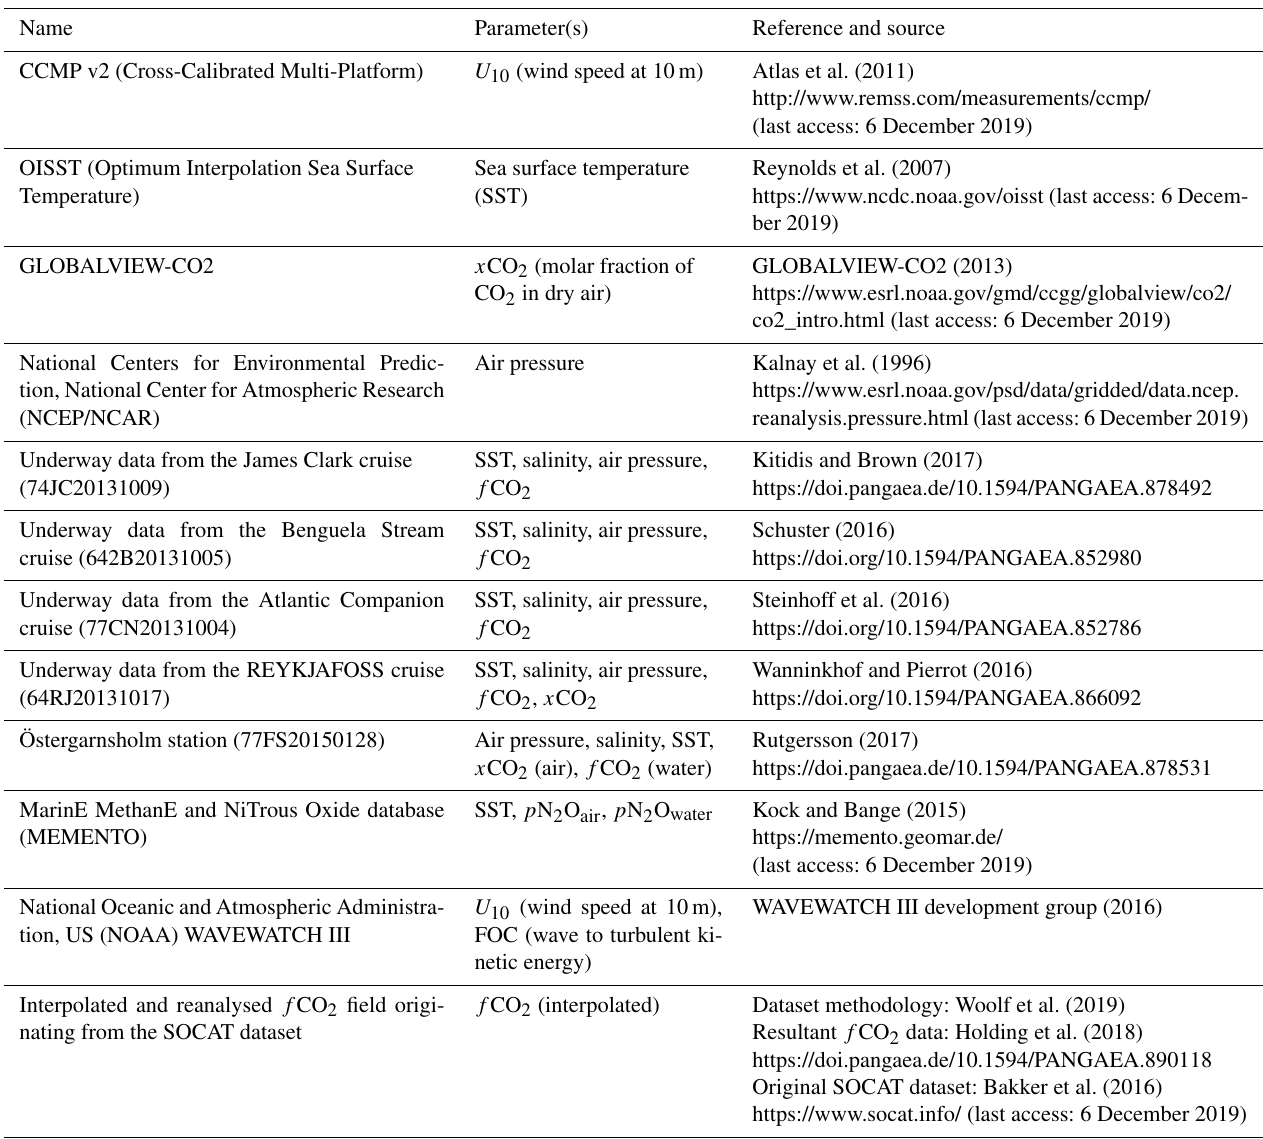
Table B1. The Earth observation in situ, model, and climatology data used in this research.